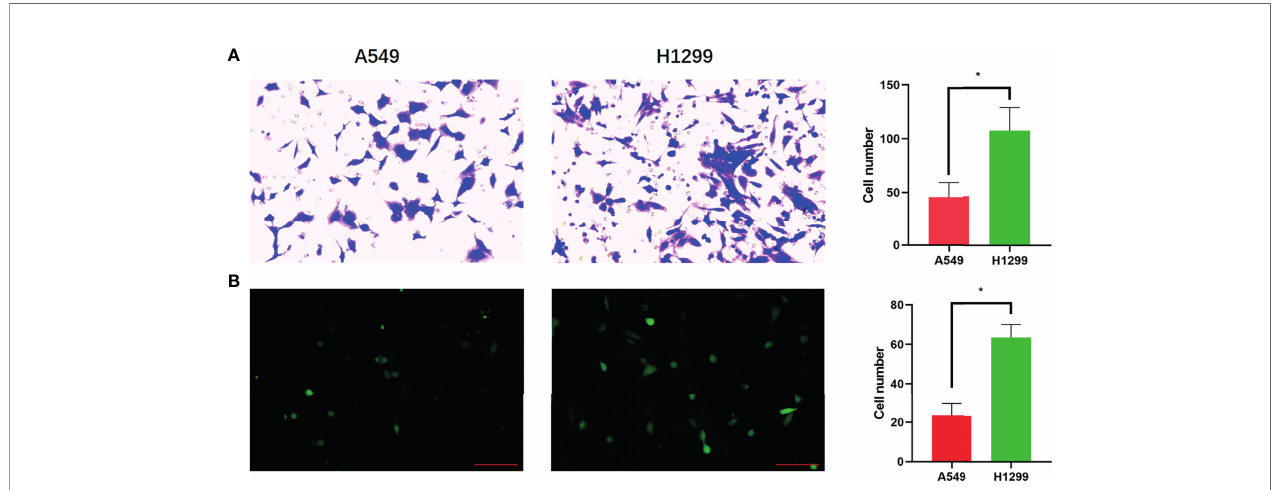
FIGURE 1 | Con fi rmation of brain metastatic cell lines. (A) Transwell assay shows the migration ability of A549 and H1299 cells and cell numbers of A549 and H1299 cells in the Transwell assay. (B) Transwell assay shows the invasive ability of A549 and H1299 cells and cell numbers of A549 and H1299. (N = 3, one-way ANOVA, *P < 0.05).